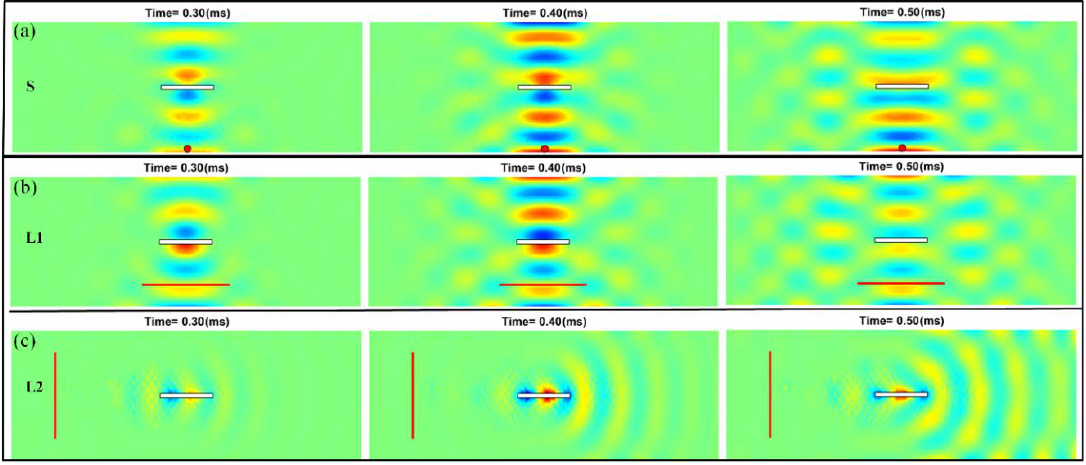
Figure 10. Differential instantaneous wave field when the excitations are ( a ) surface, ( b ) linear parallel to the long edge of the damaged plate, and ( c ) linear parallel to the short edge of the damaged plate.